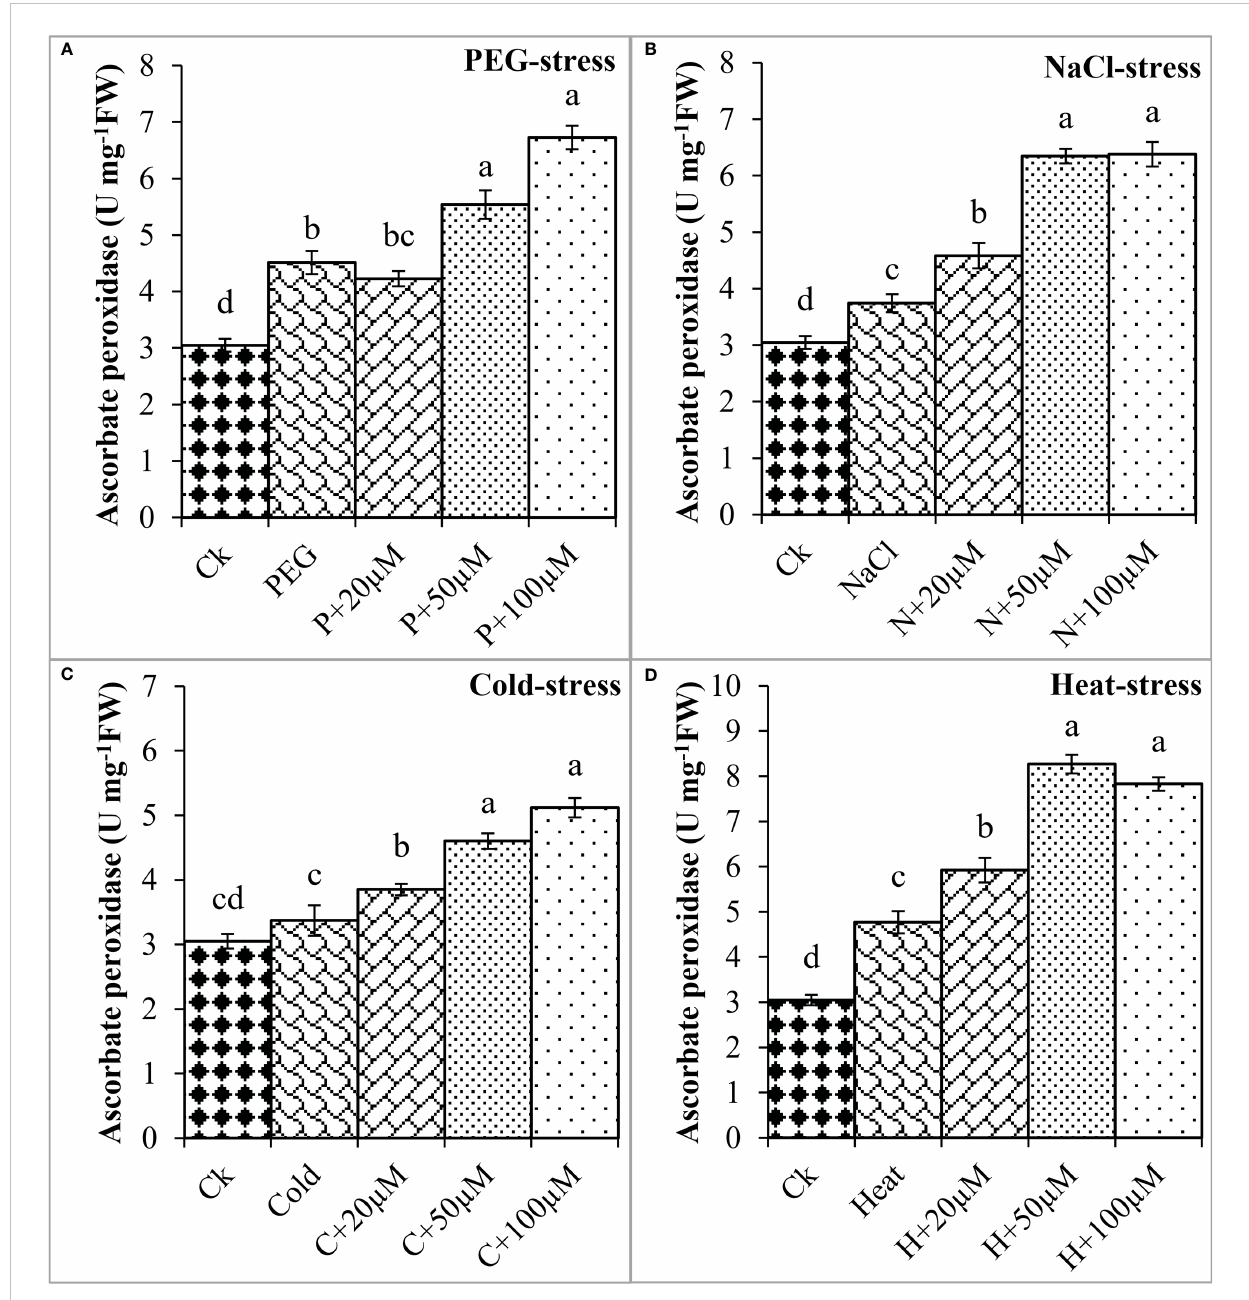
FIGURE 9 Effect of different concentrations of melatonin on the activity of Ascorbate peroxidase (APX) under PEG (A) , NaCl (B) , Cold (C) , and Heat (D) . Values are the means ± SD (n=3). Different letters on the bars show a statistical signi fi cance level at p<0.05 . Here, µM is indicating (µmole L -1